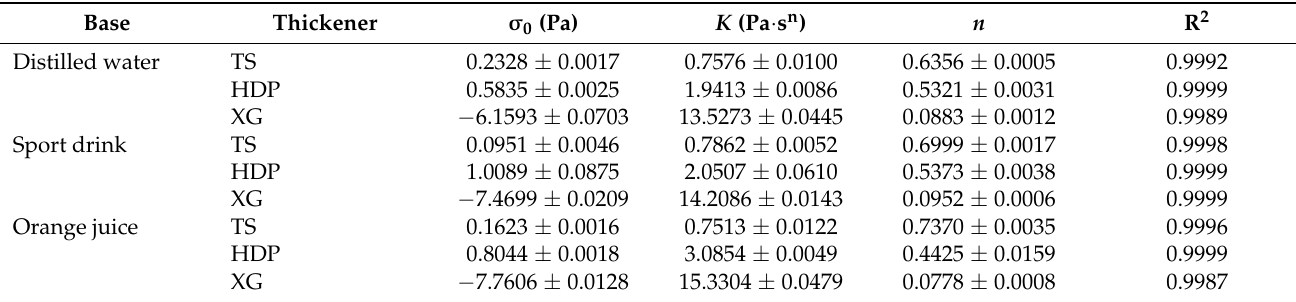
Table 3. Summary of the flow properties parameter of regression output of Herschel–Bulkley model for thickened beverages made from different commercial thickeners and fluid bases *.